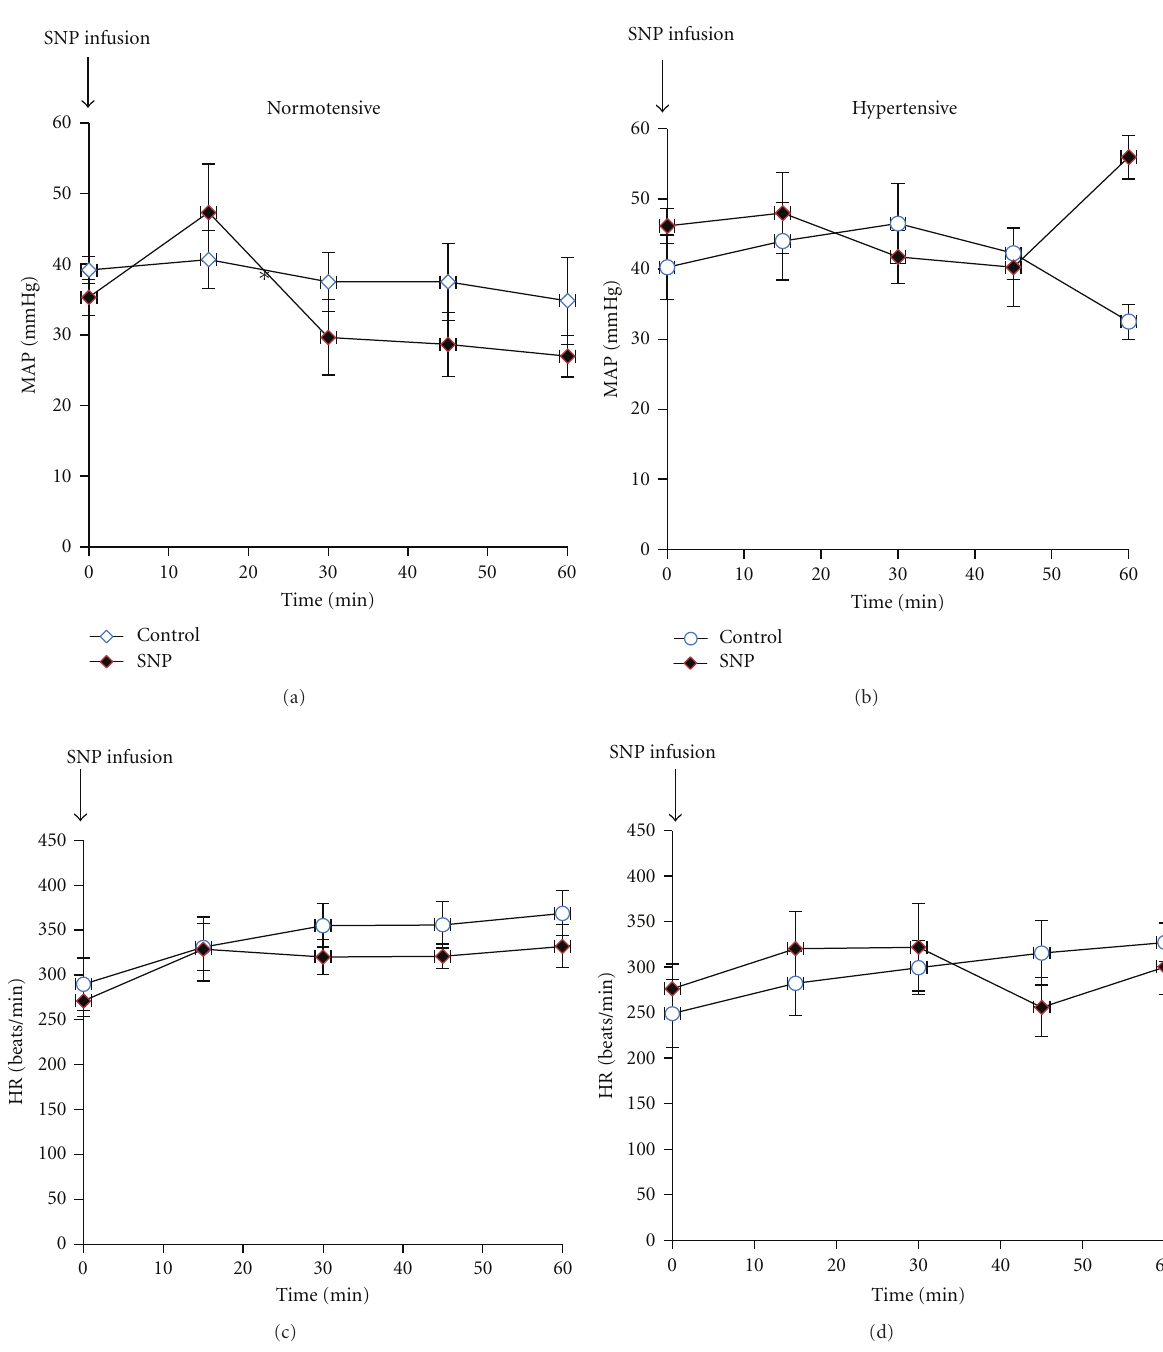
incisions closed by 3–0 chromic catgut sutures. After recov- ery of anesthesia, the animals were returned to individual cages and allowed free access to water and food. The survival rate was counted on first 4 h after experiment and every 12 h up to 72 h until the death of